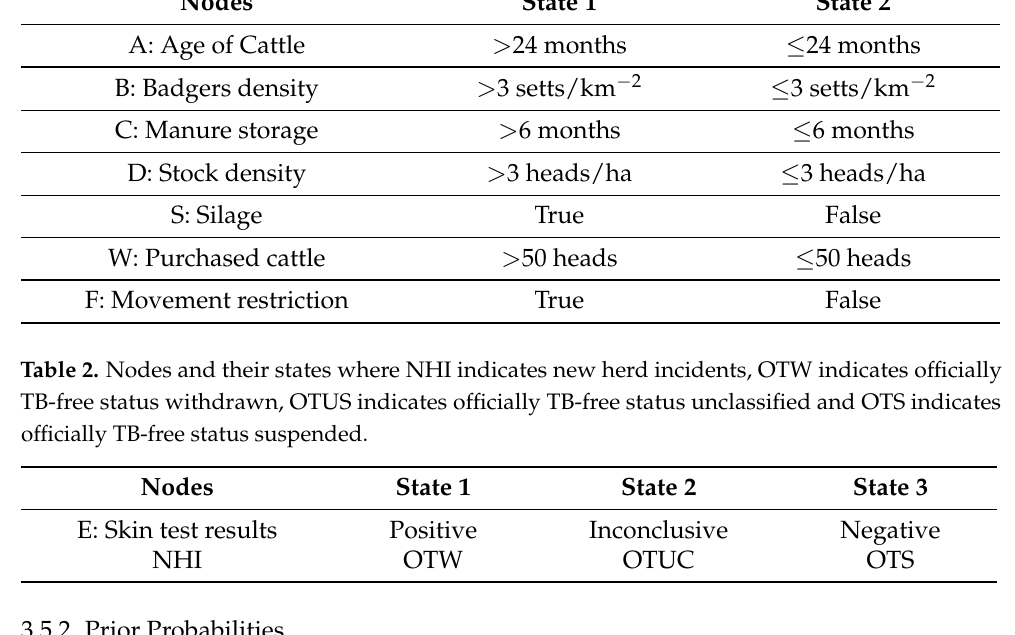
Figure 3. Static Bayesian network model. This network is used to represent the probabilistic relationships between root causes or risk factors and symptoms or evidences. Given evidence about new herd incidents (NHI), the network can compute the probabilities of the strength of various root causes of bTB. Table 1. Nodes and their states.